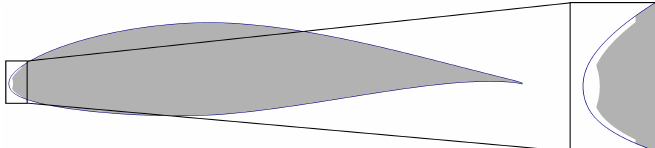
Figure 6. Sketch and close-up view of erosion modelled by a deformed leading edge as it is used in the two-dimensional CFD simulations (model for strong erosion in grey and original NACA 64-618 in